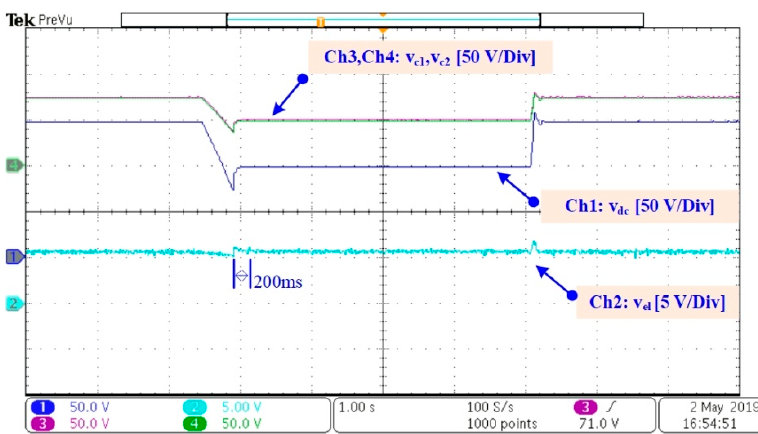
Figure 11. Input capacitors balance (dynamic test from v dc = 150 V to v dc = 100 V, then from v dc = 100 V to v dc = 150 V): channel 1: DC bus voltage (v dc ), channel 2: PEM EL voltage (v el ), channel 3: C1 capacitor voltage (v C1 ), channel 4: C2 capacitor voltage (v C2 ).